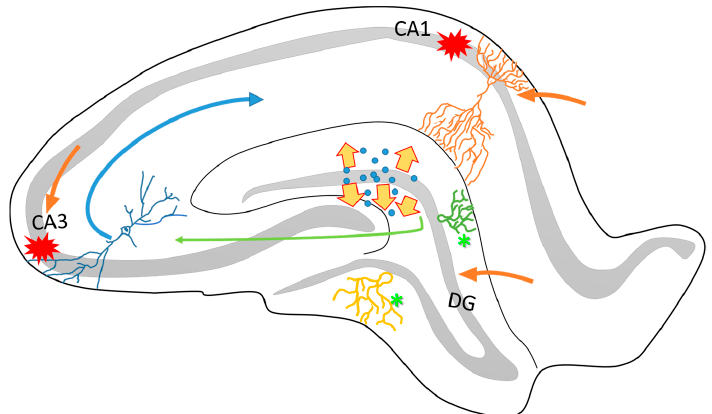
Figure 1. Schematic representation of the structural organization of the rat hippocampus. It is known that the hippocampus is connected to the entorhinal cortex through different anatomical circuitries that have been well described. Particularly, the perforant pathway projects from the DG and the CA3 to the CA1 (green and blue arrows). One of the characteristics of this circuitry is its directionality between the different neuronal layers. The DG, CA3 and the apical layers of CA1 (orange arrows) project mainly via the superficial layers of the entorhinal cortex (II and III). On the other hand, many pieces of evidence have reported that the hippocampus is highly vulnerable to cell loss via seizure activity, particularly in the CA1 and CA3 subfields (red marks). The dispersion of dentate granular cells (yellow arrows) and intense axonal sprouting (asterisks) are common in epileptogenesis process. These structural changes affects the organization and function of hippocampal circuitry and contribute to the establishment of the TLE.